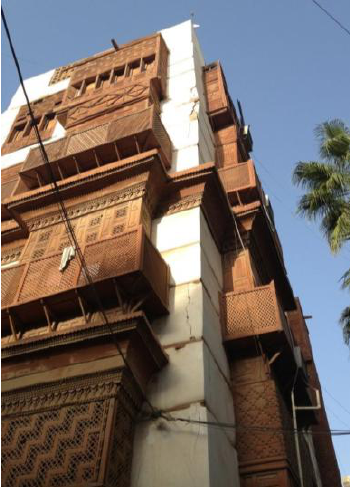
Figure 1. Farsi House Roshan and